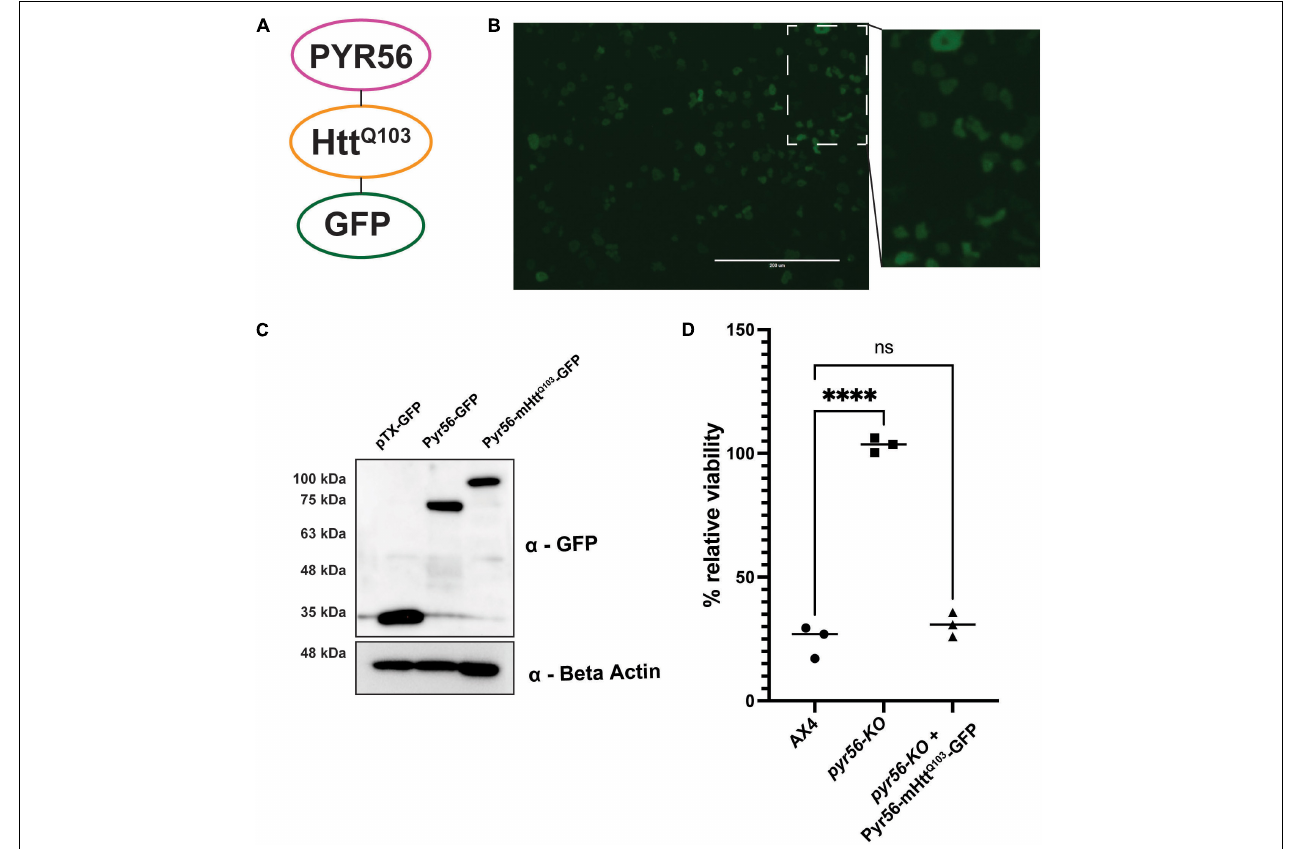
FIGURE 3 | The Pyr56-mHtt Q103 -GFP fusion protein is soluble and active in Dictyostelium . (A) The Pyr56-mHtt Q103 -GFP fusion protein is composed of the UMP synthase Pyr56, Htt exon 1 containing a tract of 103 glutamines, and a GFP reporter express by the PTX(act15/pyr56-mHtt-GFP) plasmid. (B) Pyr56-mHtt Q103 -GFP remains soluble in Dictyostelium . pyr56- KO cells expressing Pyr56-mHtt Q103 -GFP were imaged for GFP localization using an EVOS microscope. Scale bar represents 200 µ m. (C) Pyr56-mHtt Q103 -GFP is expressed in Dictyostelium . pyr56- KO cells expressing either empty vector (pTxGFP), Pyr56 GFP or Pyr56-mHtt Q103 -GFP were lysed, and lysates were run on a gradient SDS-PAGE gel. Gels were analyzed by western blot analysis to probe for GFP expression, indicating that Pyr56-mHtt Q103 -GFP is expressed in Dictyostelium and runs at the expected size. (D) Expression of Pyr56-mHtt Q103 -GFP in the pyr56- KO strain rescues sensitivity to 5-FOA. 2 × 10 3 cells/mL of either wild-type, pyr56- KO, or pyr56- KO expressing Pyr56-mHtt Q103 -GFP were treated with 500 µ g/mL 5-FOA and viability was measured at t = 48 h by luminescence using the CellTiter-Glo Viability Assay ( n = 3). Samples were analyzed by one-way ANOVA with multiple comparisons, ∗∗∗∗ indicates p <